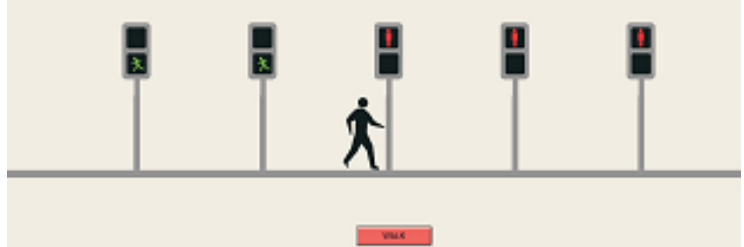
Figure 1. Example of Kimbrough and Vostroknutov [8] rule-following